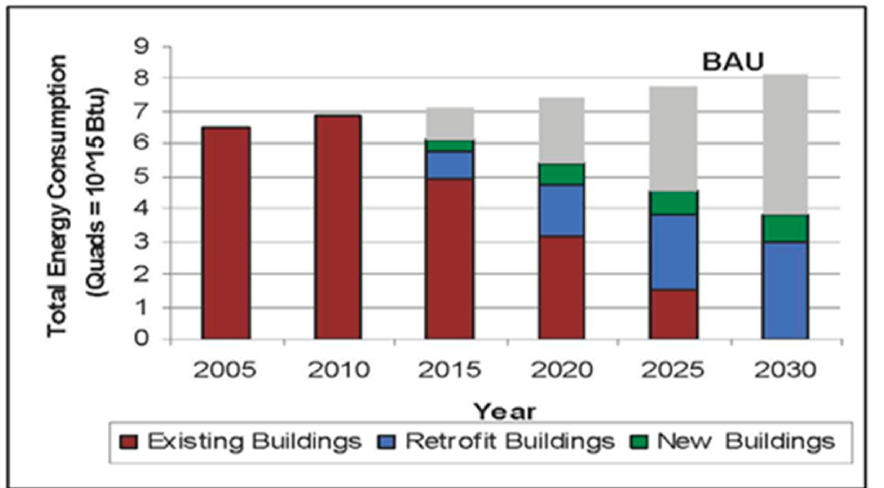
Figure 4. What will it take to achieve 2030 targets, slide prepared in 2008 by the Lawrence Berkeley National Laboratory [41] (reprinted with permission).